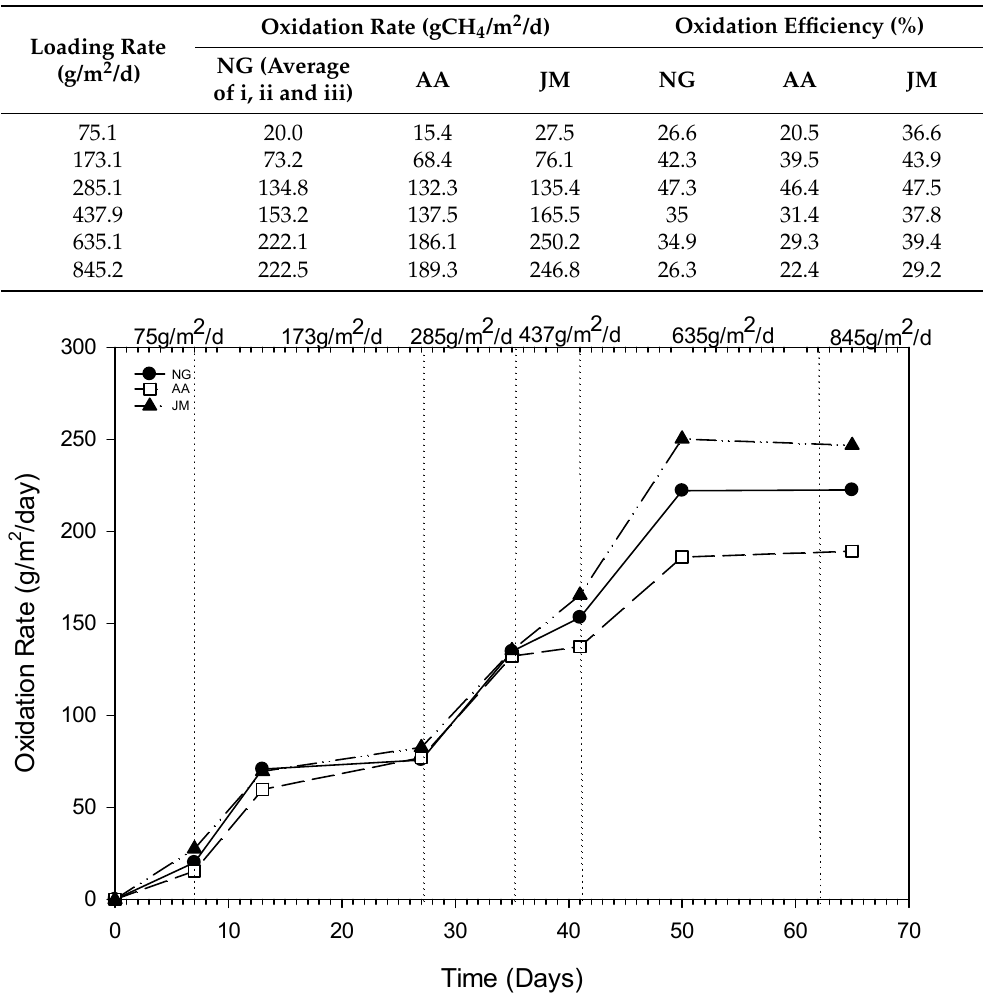
Table 3. Average oxidation rate and oxidation efficiencies of columns.